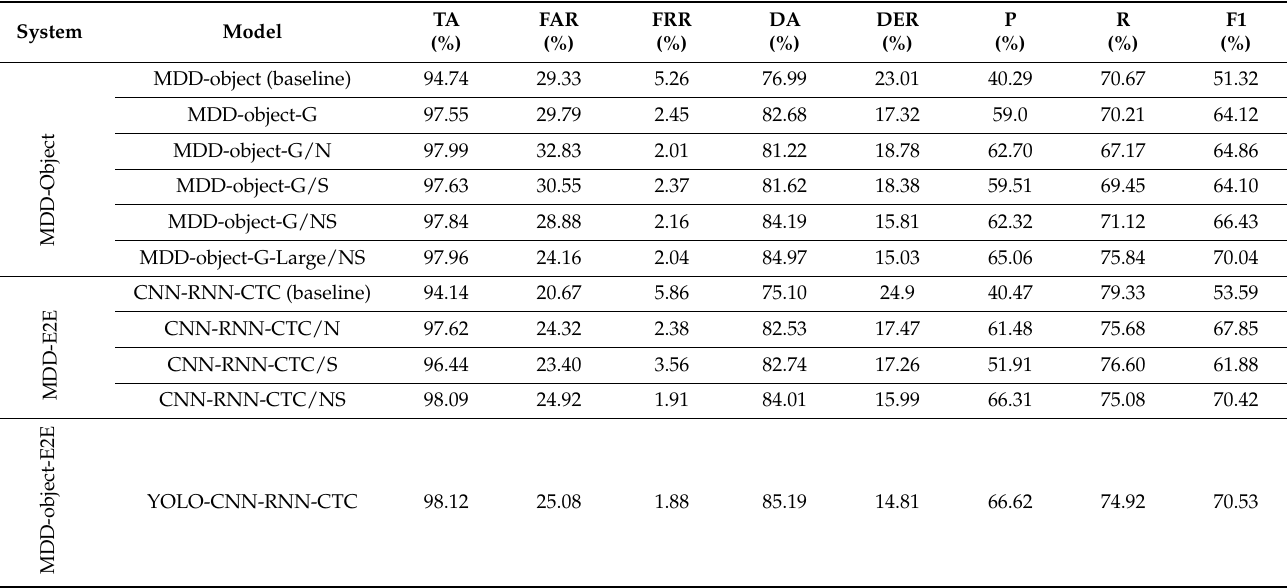
Table 11. MDD results of the proposed models and the baselines.